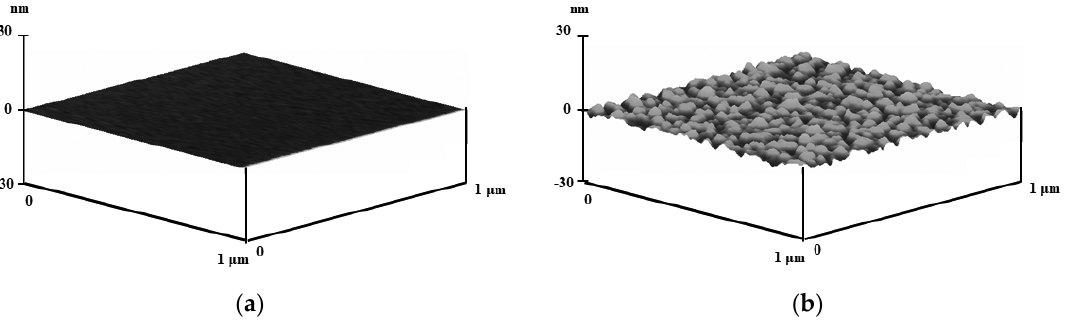
Figure 2. Surface morphology ( a ) before the lipid vesicle adsorption ( b ) after the adsorption (contact mode, with the tip of 15~20 nm radius and 0.02 N/m spring). Table 1. Change rate of the steric forces for the dipalmitoylphosphatidylcholine vesicles with respect to the ratio of mucin to lipid.